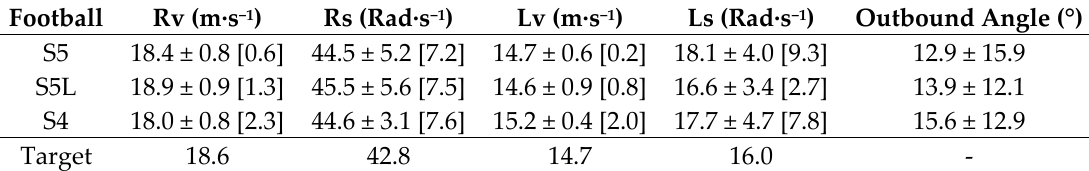
Table 1. Mean and standard deviation for football velocity (Rv and Lv) and spin (Rs and Lv) of inbound trajectories, and outbound trajectory angle (transverse plane), for S5, S5L, and S4 footballs. Football